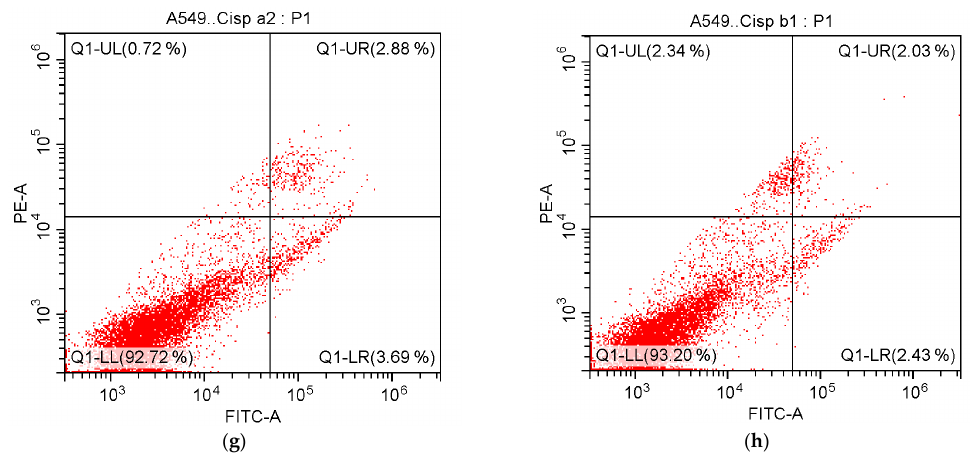
Figure 5. Flow cytometric analysis of A549 cells treated with IC 50 /2 and IC 50 concentrations of compounds 3b , 4a, and cisplatin. At least 10,000 cells were analyzed per sample, and quadrant analysis was performed. Q1-LR, Q1-UR, Q1-LL, and Q1-UL quadrants represent early apoptosis, late apoptosis, viability, and necrosis, respectively. ( a ) Control; ( b ) Control; ( c ) Compound 3b at IC 50 /2 concentration; ( d ) Compound 3b at IC 50 concentration; ( e ) Compound 4a at IC 50 /4 concentration; ( f ) Compound 4a at IC 50 /2 concentration; ( g ) Cisplatin at IC 50 /2 concentration; ( h ) Cisplatin at IC 50 concentration. values of 32.50 and 45.33 µM as compared to GSK690693 (IC 50 = 5.93 µM) (Table 6). Table 6. Akt inhibitory effects of compounds 3b , 4a , GSK690693, and cisplatin in A549 cells.